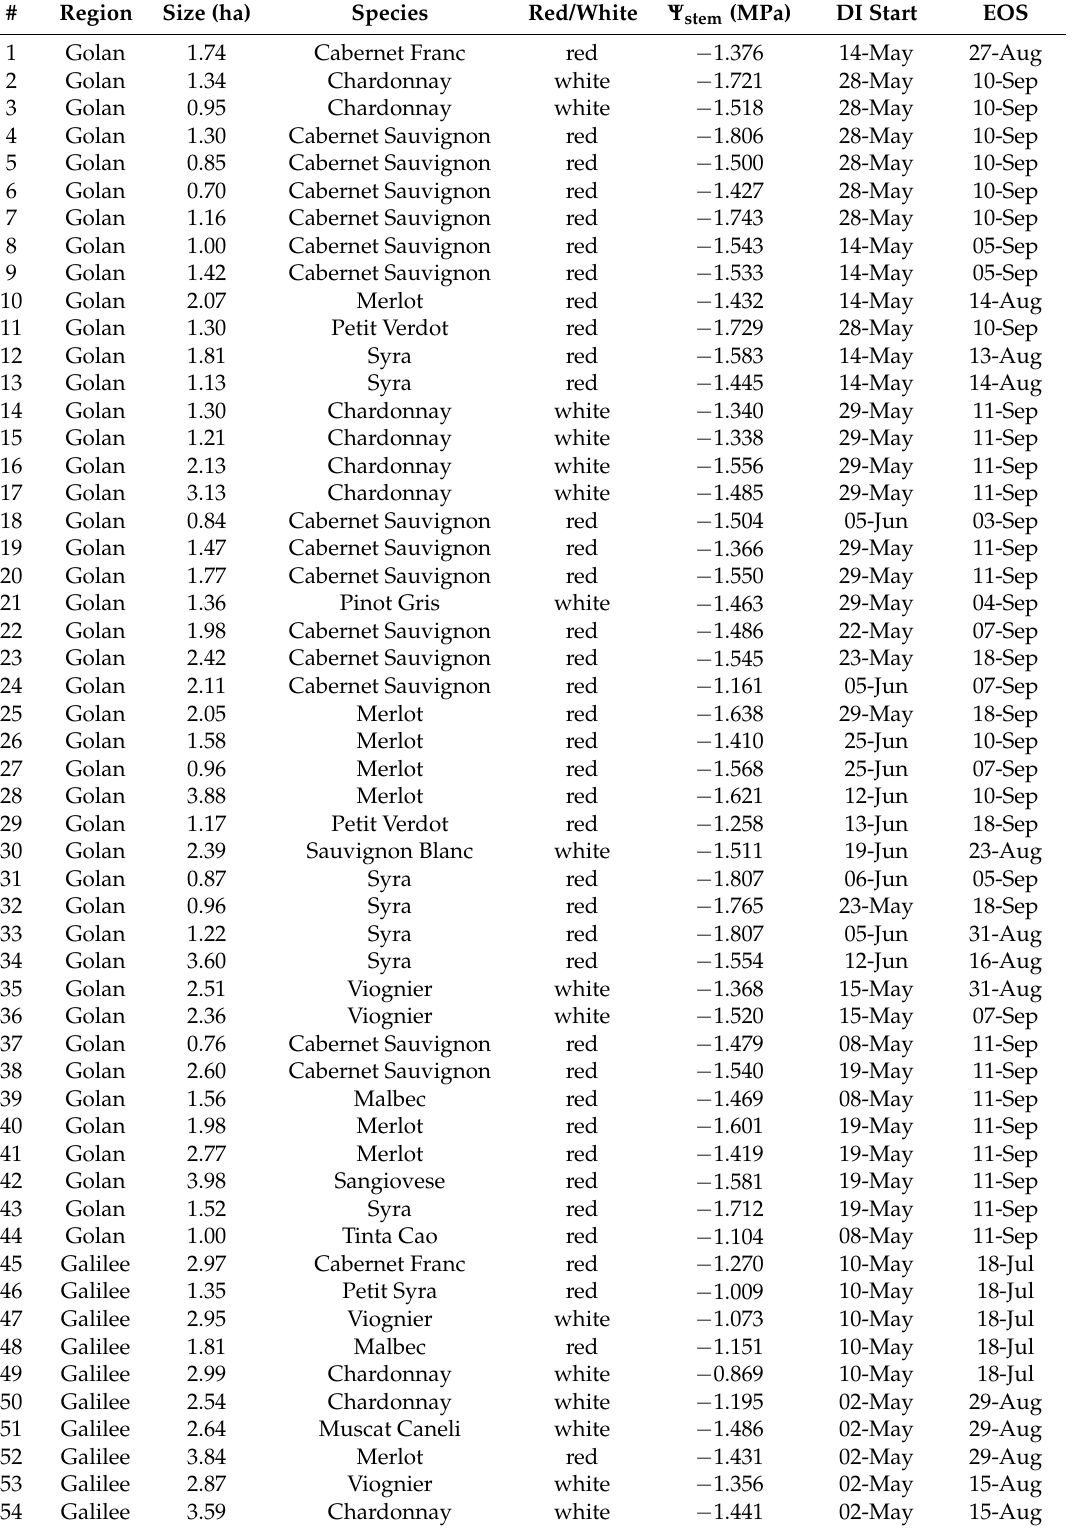
Table A1. General characteristics of the 82 vineyards used in this study. The region, size of the vineyard (in hectares) and species are shown alongside the minimum (most negative) seasonal Ψ stem (MPa) in the vineyard and the DI start and EOS dates. In bold is Mevo Beitar